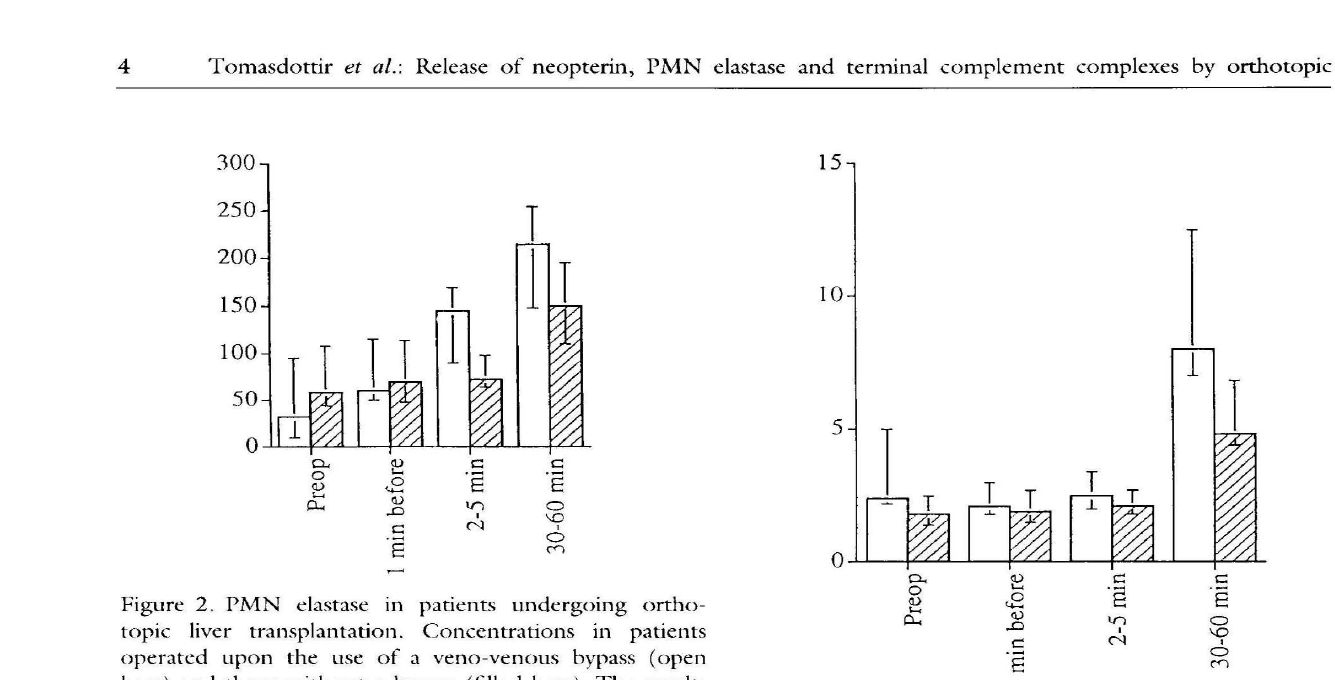
Figure 2. PMN elastase in patients undergoing ortho topic liver transplantation. Concentrations in patients operated upon the use of a veno-venous bypass (open bars) and those without a bypass (filled bars). The results are given as median and 25th-75th percentiles. muscle relaxation. All patients received a contin